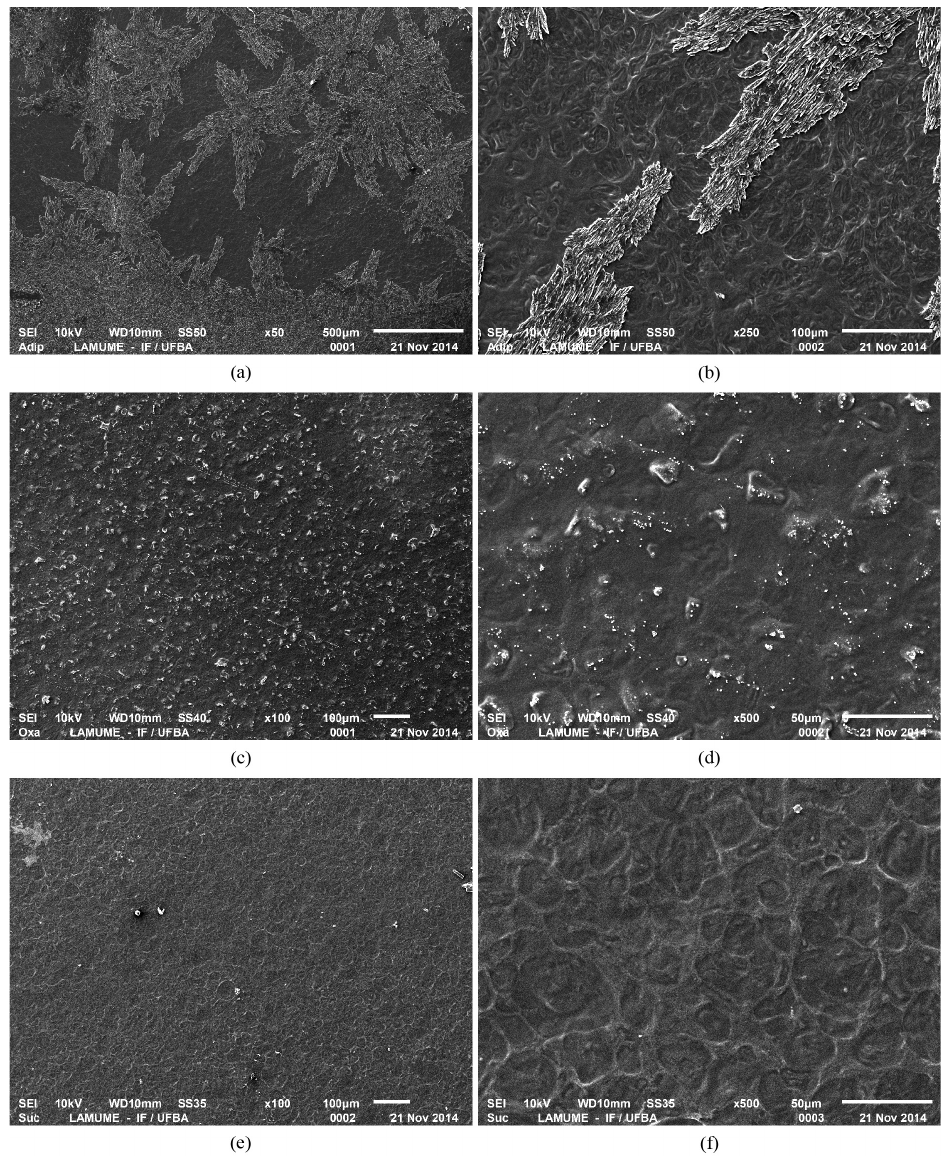
Figure 5. Scanning electron micrographs of the surface of ADIP 5% in 50x (a) and 250x (b), OXA 5% in 100x (c) and 500x (d), SUC 5% in 100x (e) and 500x